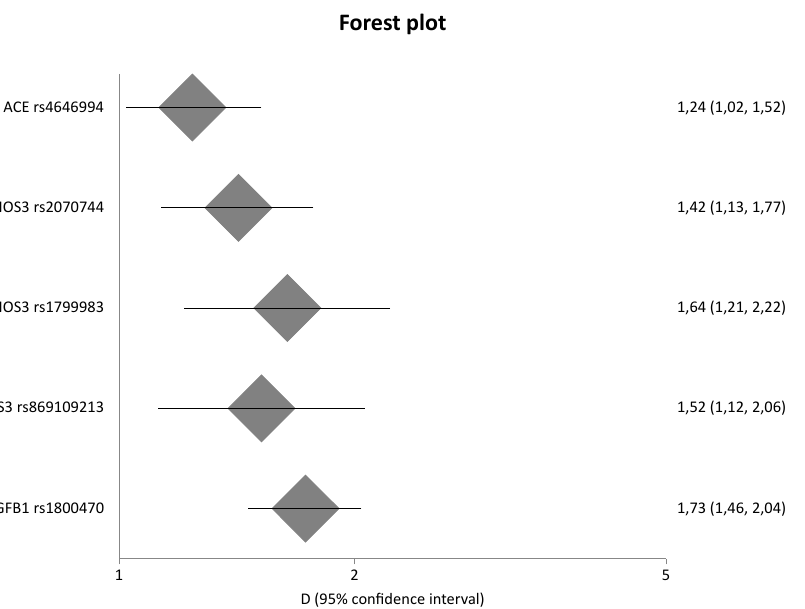
Figure 4. Meta-analysis results of healthy controls versus cases based on genotype counts.